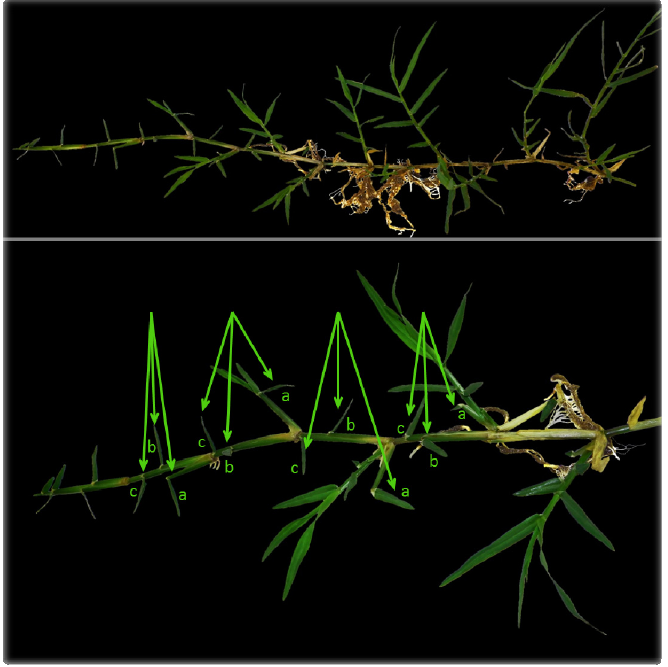
Figure 1. Triplet structure of Cynodon spp. cv. Tifton-85 showing cluster formation at regular intervals of three phytomers. Letters a, b and c indicate leaf 1, leaf 2, and leaf 3 of each cluster,